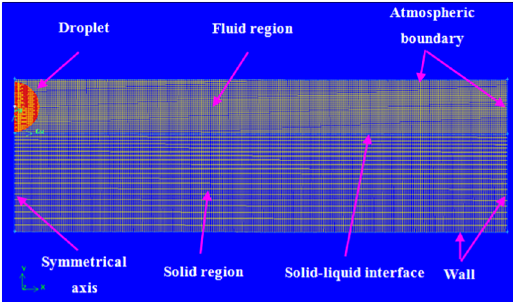
Figure 1. Diagram of calculation